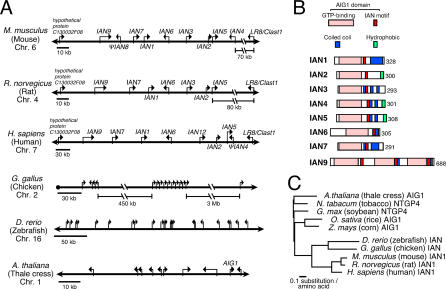
IAN Family Genes(A) The cluster of IAN family genes in the genome of indicated species. Mouse IAN genes and their orthologs in human and rat are indicated. For chicken, zebrafish, and thale cress, arrows indicate genes that putatively encode AIG1-domain-containing proteins. In chicken, 19 genes are predicted to encode AIG1 domain–containing proteins, and arrows indicate 15 genes clustered on Chromosome 2. In zebrafish, a cluster of 23 genes was found on Chromosome 16. In thale cress, ten out of 14 predicted genes are clustered on Chromosome 1.(B) Predicted structures of mouse IAN family proteins. Numbers refer to amino acid residues of full-length proteins.(C) A neighbor-joining tree of the AIG1 domain of IAN proteins.
A. thaliana AIG1, residues 44–243;
N. tabacum NTGP4 (AAD09518), residues 23–222;
G. max NTGP4 (BI316235), residues 1–118;
O. sativa AIG1 (CAE04223), residues 31–230;
Z. mays AIG1 (AW120061), residues 1–200;
D. rerio IAN (BC053197), residues 1–200;
G. gallus IAN (XP_427942), residues 3–202;
M. musculus IAN1, residues 31–230;
R. norvegicus IAN1, residues 31–230;
H. sapiens IAN1, residues 45–244. No IAN genes were found in the genomes of
Drosophila melanogaster (fly),
Anopheles gambiae (mosquito),
Ciona intestinalis (sea squirt),
Caenorhabditis elegans (nematode),
Saccharomyces cerevisiae (yeast), and all bacteria and archea.